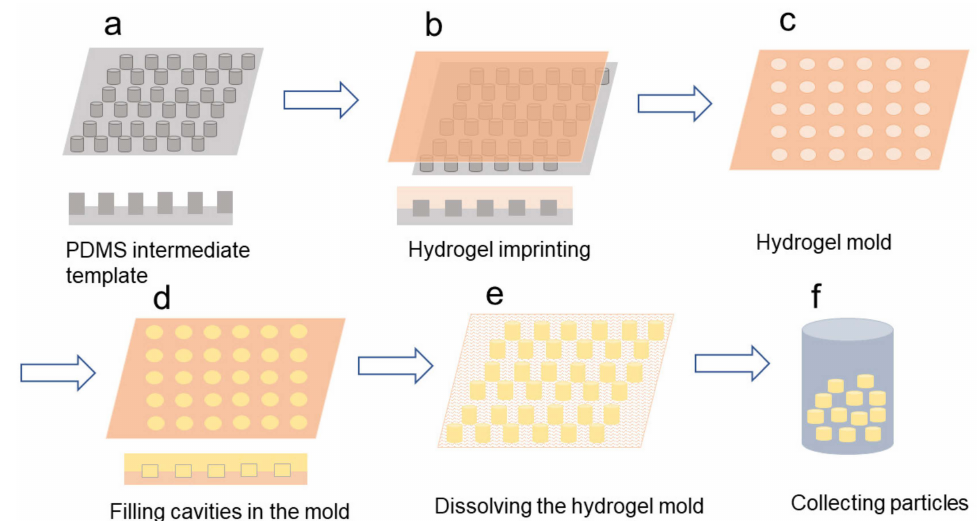
Figure 7. Schematic diagram of the hydrogel template fabrication process for producing drug-loaded microparticles: Steps ( a – e ): ( a ) PDMS intermediate template with 20 µ m diameter vertical posts was formed using a designed silicon wafer master template with patterns of 20 µ m diameter wells; ( b ) casting hydrogel solution on the surface of the PDMS template; ( c ) hydrogel template with 20 µ m diameter wells; ( d ) casting drug/polymer solution into the wells of the hydrogel template; ( e ) dissolution of the hydrogel template; and ( f ) collection of the microparticles (adapted from Zhu. et al., 2019